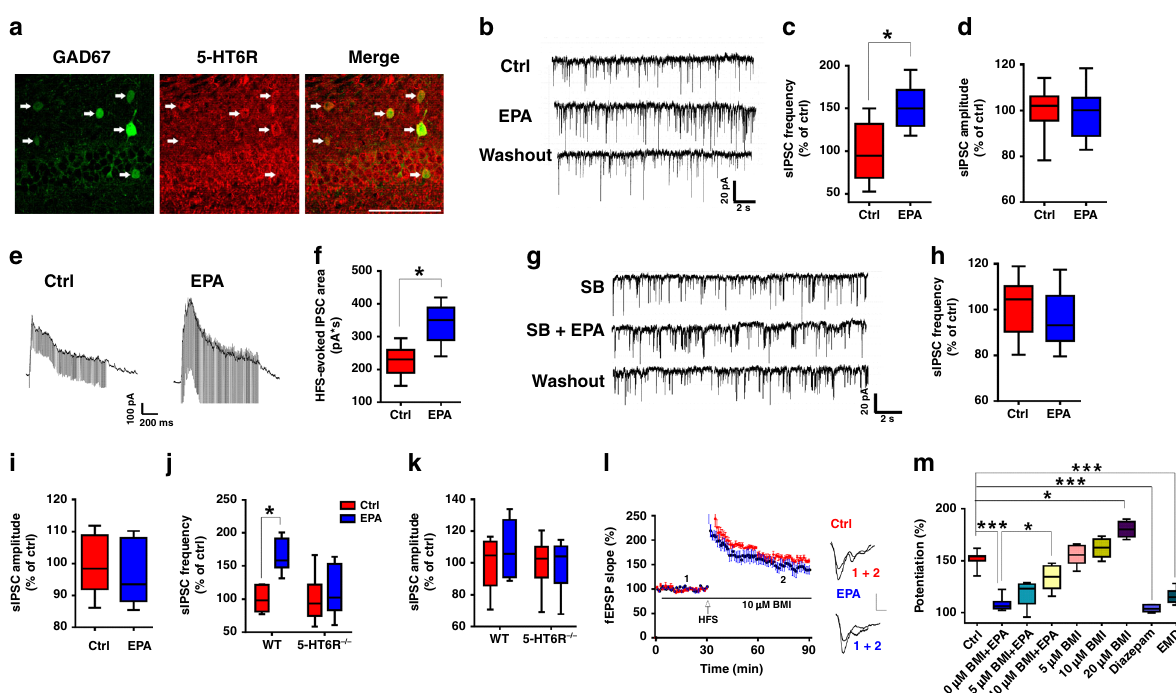
Fig. 6 EPA modulated GABAergic transmission via the 5-HT 6 R. a Coronal sections of the hippocampal CA1 of GIN-GFP mice were stained with anti-5- HT 6 R antibody. The arrows indicate neurons double positive for both 5-HT 6 R and GAD67. Scale bar: 100 µ m. b – d Effects of EPA on sIPSCs frequency and amplitude ( n = 9 cells from fi ve mice; two-tailed Student ’ s t -test, c , P = 0.013; d , P = 0.85). Scale bars: 20 pA, 2 s. e , f HFS-evoked IPSCs in hippocampal CA1 neurons with or without EPA treatment ( n = 9 – 11 cells from four mice; two-tailed Student ’ s t -test, P = 0.016). g – i EPA was unable to enhance sIPSCs in the presence of the 5-HT 6 R antagonist ( n = 10 cells; two-tailed Student ’ s t -test; f , P = 0.868; g P = 0.798).Scale bars: 20 pA, 2 s. j , k Increased frequency of sIPSCs induced by EPA disappeared in 5-HT 6 R KO mice. The average sIPSC frequency is shown in h (two-tailed Student ’ s t -test; WT, P = 0.043 and KO, P = 0.604), and the amplitude is shown in i (two-tailed Student ’ s t -test; WT, P = 0.546 and KO, P = 0.907) ( n = 9 cells from four mice/group). l , m The